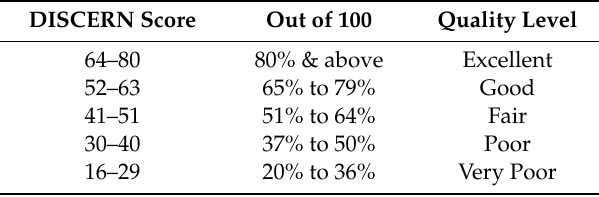
Table 2. DISCERN grading and their quality